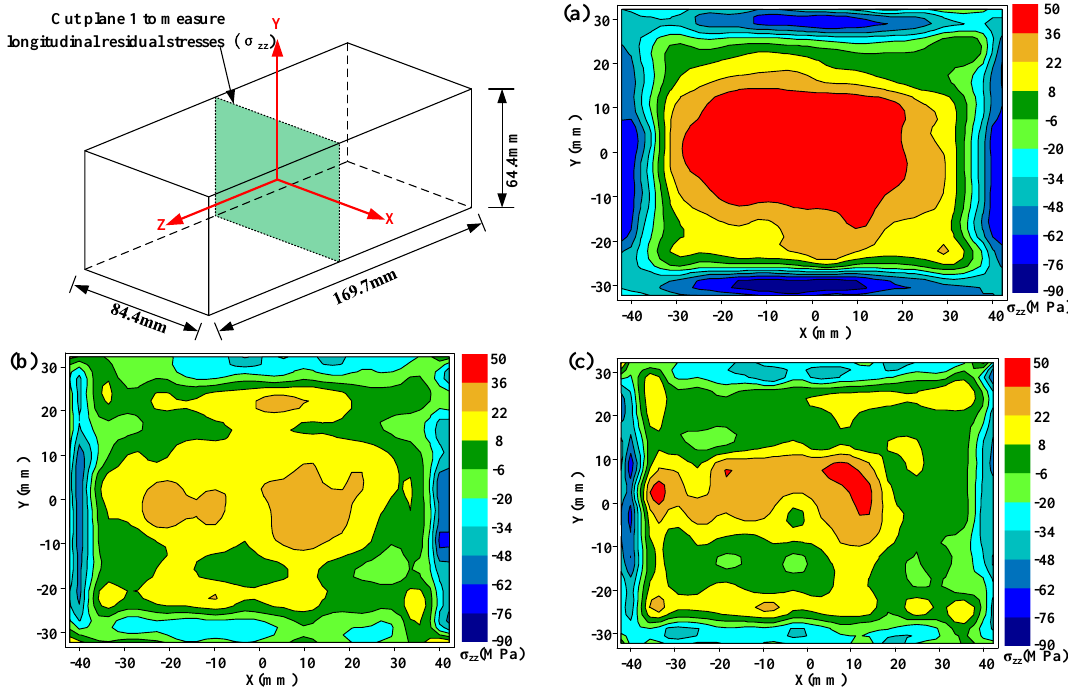
Figure 7. Longitudinal residual stresses ( σ zz ) on cut plane 1 in three different conditions: ( a ) as-quenched specimen; ( b ) heat-treated specimen; ( c ) cold-treated specimen.